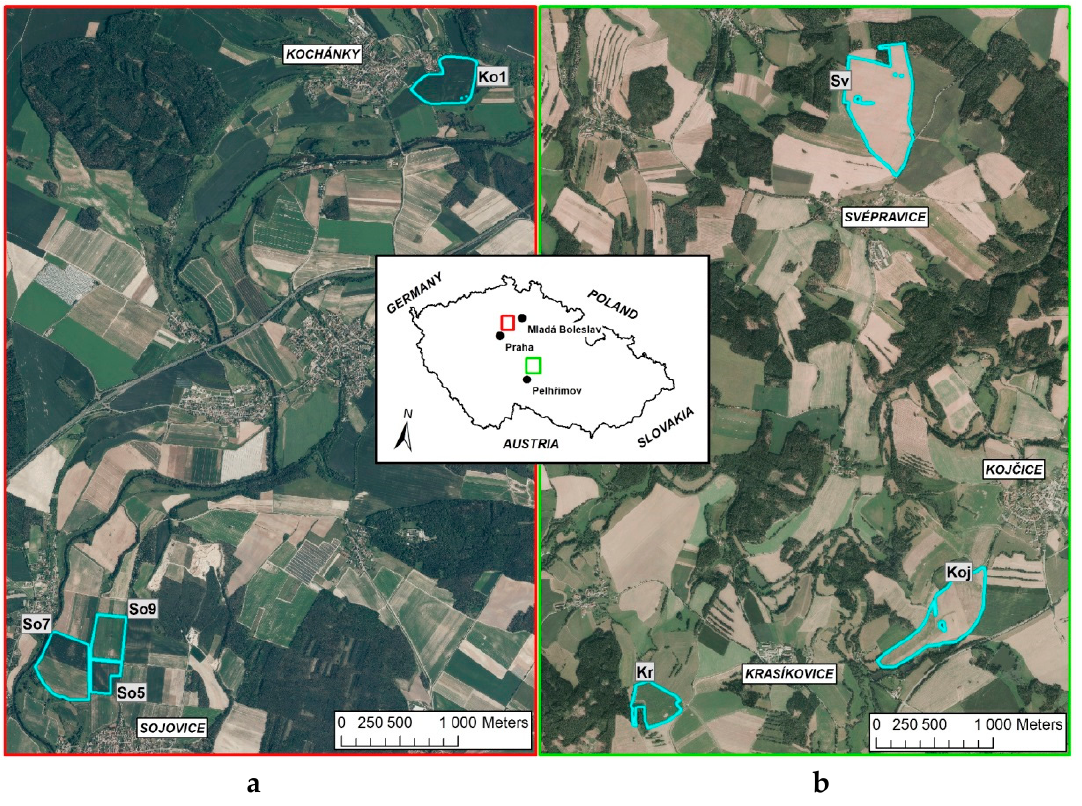
Figure 1. Map of experimental sites: ( a ) Lower Jizera River region; ( b ) Bohemian–Moravian Highlands region.